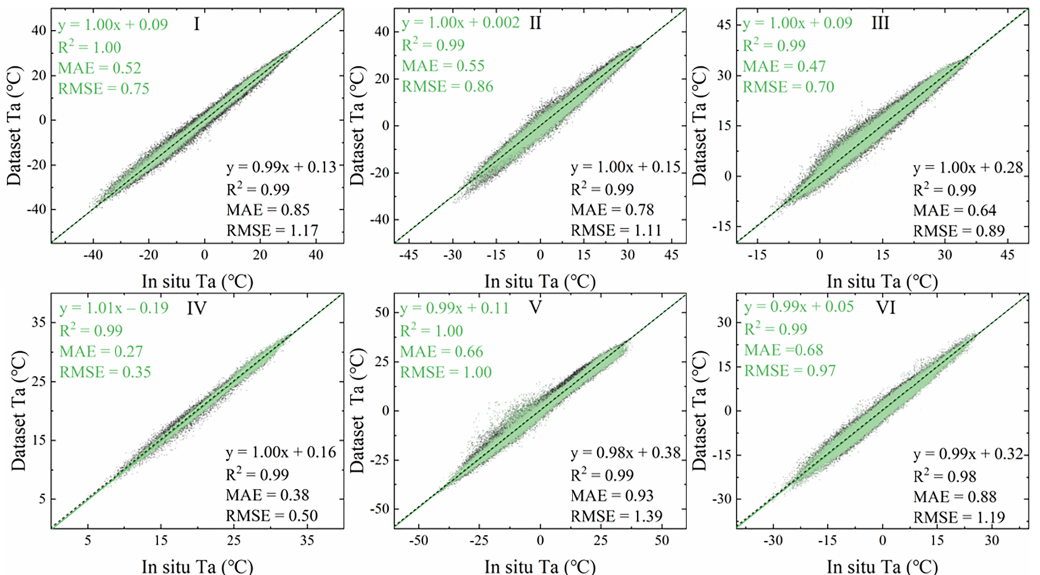
Figure 11. Scatter diagrams of the original T avg and reconstructed results versus their corresponding ground station data in six natural subregions (I, II, III, IV, V, and VI). Gray points indicate low-quality pixel values in the original T avg data, green points represent the values in the after-calibration T avg dataset; the statistical accuracy measures ( R 2 , MAE, and RMSE) are also